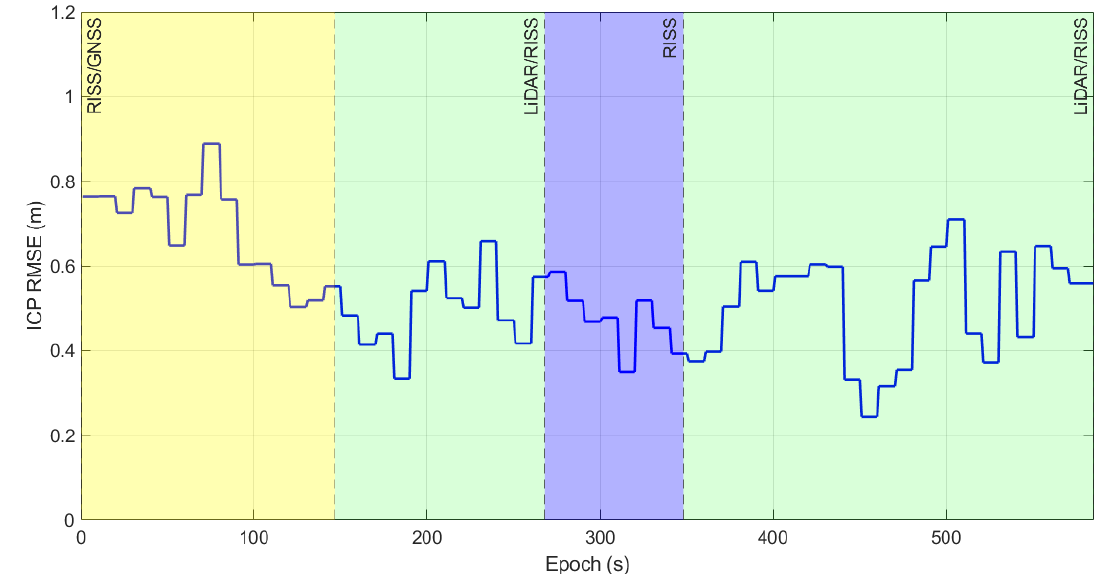
Figure 24. The RMSE of the ICP Calculated in the Selected Scenario.